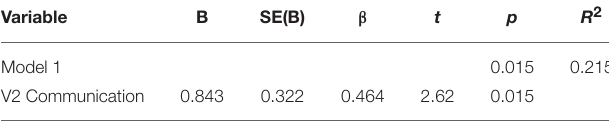
TABLE 11 | Stepwise regression analysis for variables predicting visit 3 subject—what question comprehension in ASD children ( N = 27). Variable